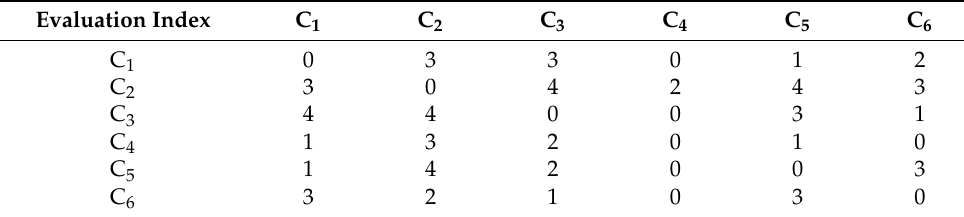
Table 8. Direct correlation matrix Y 3 between indicators of decision maker D 3 .